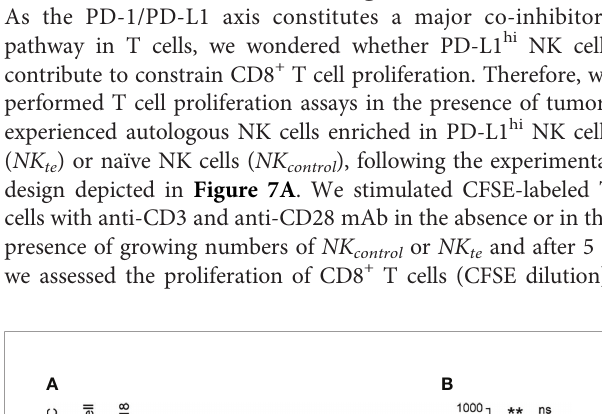
( Figure 5A ). Accordingly, monocytes cultured with NK cells and K562 cells (or RCC cell lines, not shown ) produced similar amounts of IL-18 than PBMC cultured with tumor cells ( Figure 5B ), and separation of monocytes from NK cells and tumor cells by transwells abrogated IL-18 secretion ( not shown ).